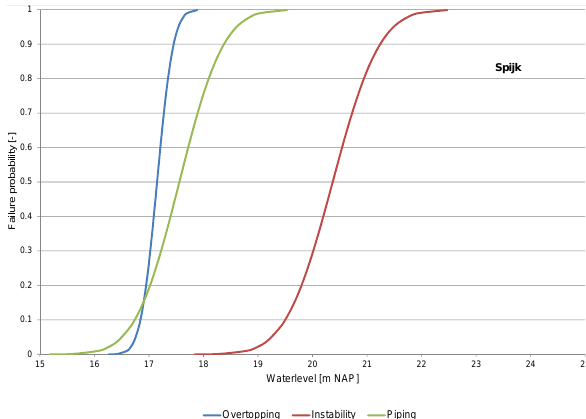
Figure 4. The fragility curves for the location Spijk upstream along the Rhine